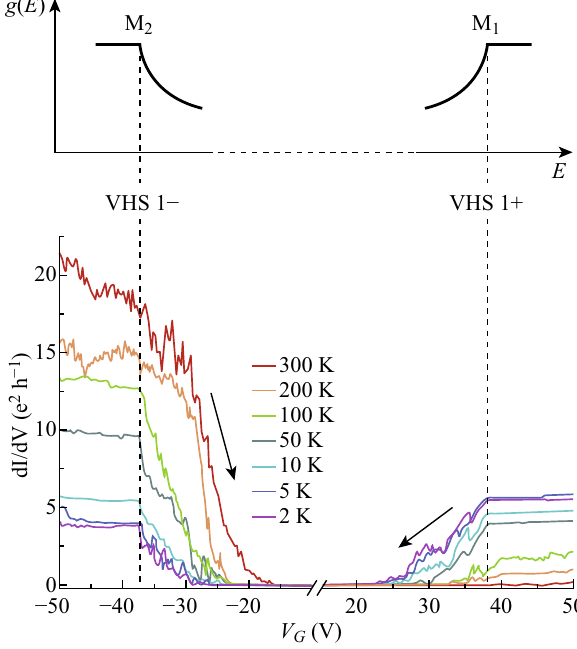
Fig. 2 Differential conductance as a function of back-gate voltage for the suspended SWNT transistor at different temperatures. The black arrows indicate the sweep direction of the gate voltage. At temperature below 100 K, two critical saddle points appear at gate voltages of - 37.4 and 38.0 V, respectively. The two vertical dashed lines correspond to the onsets of the